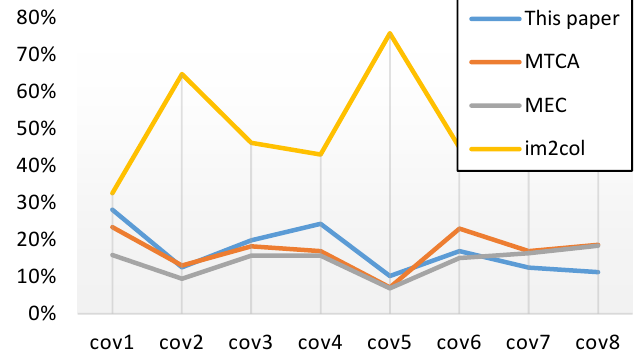
Figure 14. The storage overhead comparison between different convolution algorithms.